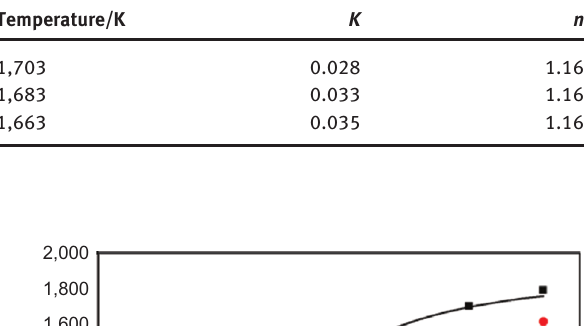
Table 3: The parameter value fitted by experiment data. Temperature/K